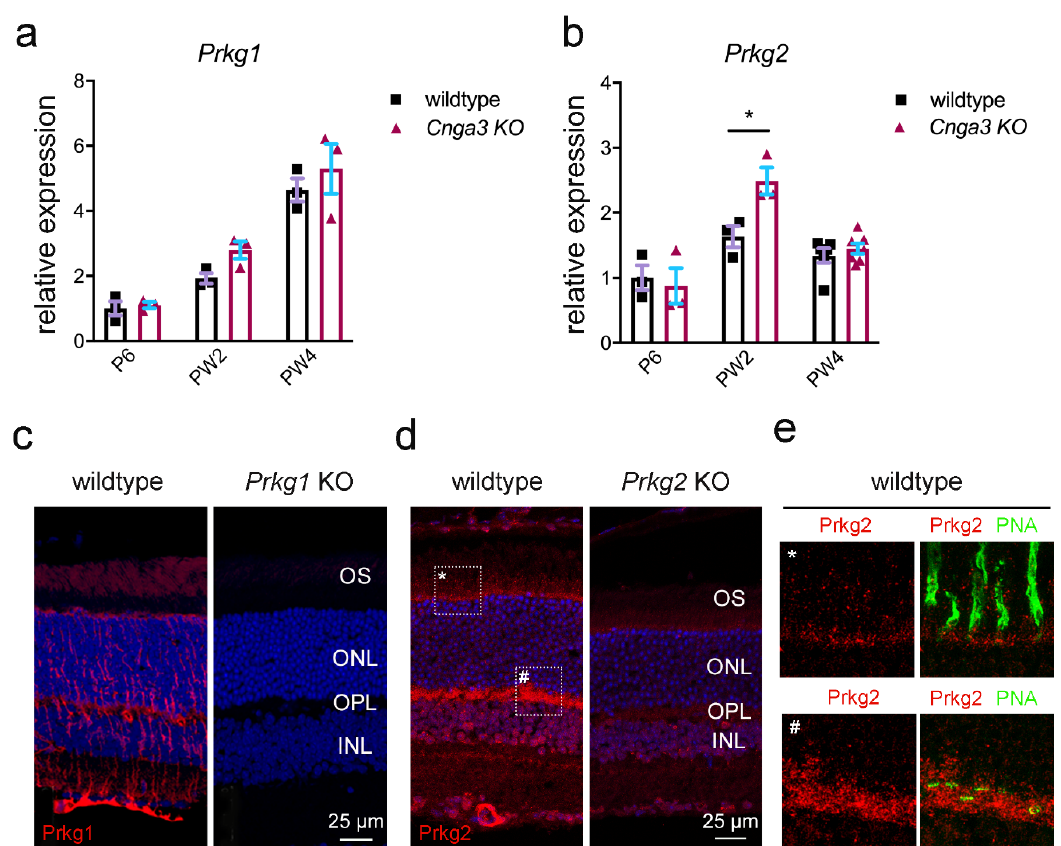
Figure 2. Expression of the cGMP dependent kinases Prkg1 and Prkg2 in wildtype and Cnga3 KO retina. ( a , b ) Relative Prkg1 ( a ) and Prkg2 ( b ) transcript levels at indicated time points. While Prkg1 is expressed at similar levels in wildtype and Cnga3 KO retina ( a ), there is a transient significant upregulation of Prkg2 transcript in the Cnga3 KO retina around eye opening (PW2) ( b , n = 3–6, * p < 0.01, 1-way-ANOVA). ( c – e ) Immunolocalization signal for Prkg1 ( c ) and Prkg2 protein ( d , e ) in the mouse retina. ( c ) The intense Prkg1 signal (red) is mostly confined to Müller glia cells and blood vessels with additional faint signal in photoreceptor outer segments (OS). ( d ) Intense Prkg2 signal is found in photoreceptor inner segments (see higher magnification view on marked regions in panel ( e )), synapses in the outer plexiform layer (OPL), some inner nuclear layer (INL) cells and in blood vessels. Panels c and d show Hoechst nuclear dye signal in blue and panel E shows the cone marker peanut agglutinin (PNA) signal in green. Tissue from the corresponding knockout mouse lines ( Prkg1 KO in C and Prkg2 KO in ( d )) did not produce a signal similar to the wildtype. The scale bar in c and d applies to both images, respectively. ( e ) Magnification view of the corresponding regions (*,#) marked with dotted rectangles in the left (wildtype) image of ( d ).Error bars shown are SEM. ONL, outer nuclear layer; P, postnatal day; PW, postnatal